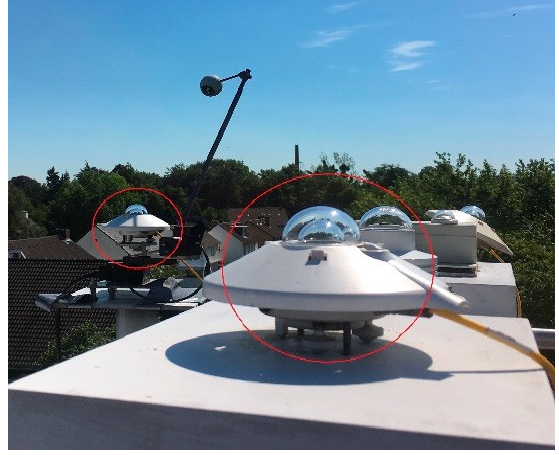
Figure 1. Photo of a pyranometer [6].